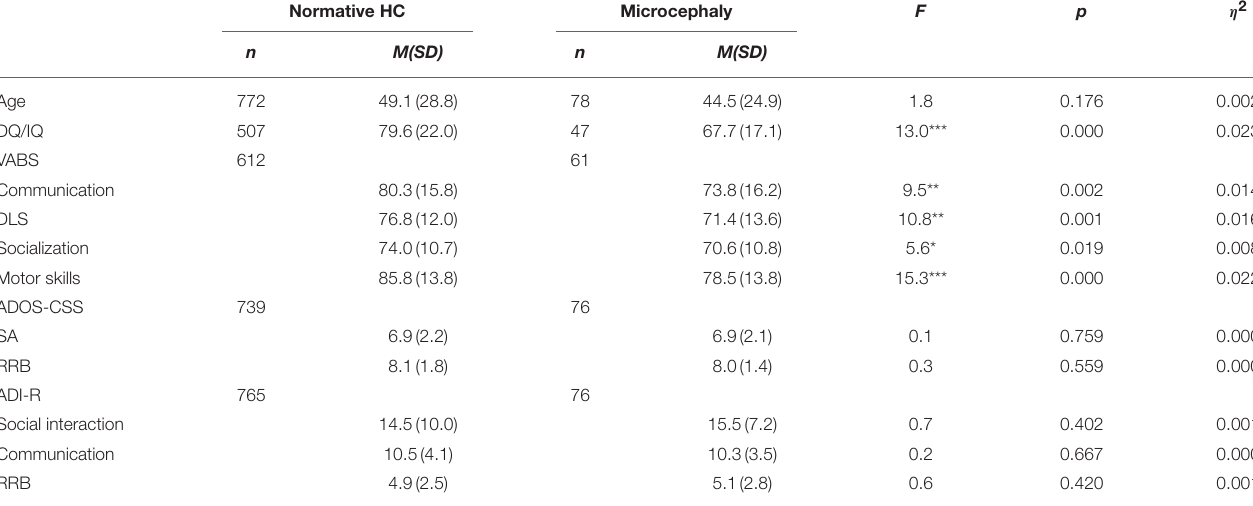
TABLE 2 | Mean and SD of cognitive scores, VABS scores and autism severity measures for the normative and the microcephaly groups. Normative HC Microcephaly F p η 2